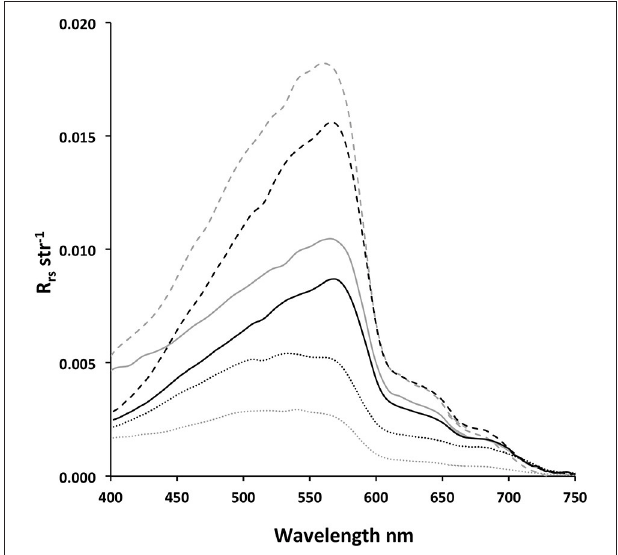
FIGURE 11 | Comparison of remote sensing reflectance derived from in situ measurements of the coconut patch reef collected on 12 February 2017 (black curves) and high-altitude AVIRIS imagery collected on 3 March 2017 (gray curves) representing coral (solid curves), uncolonized sediment (dashed curves) and deep water adjacent to the reef (dotted